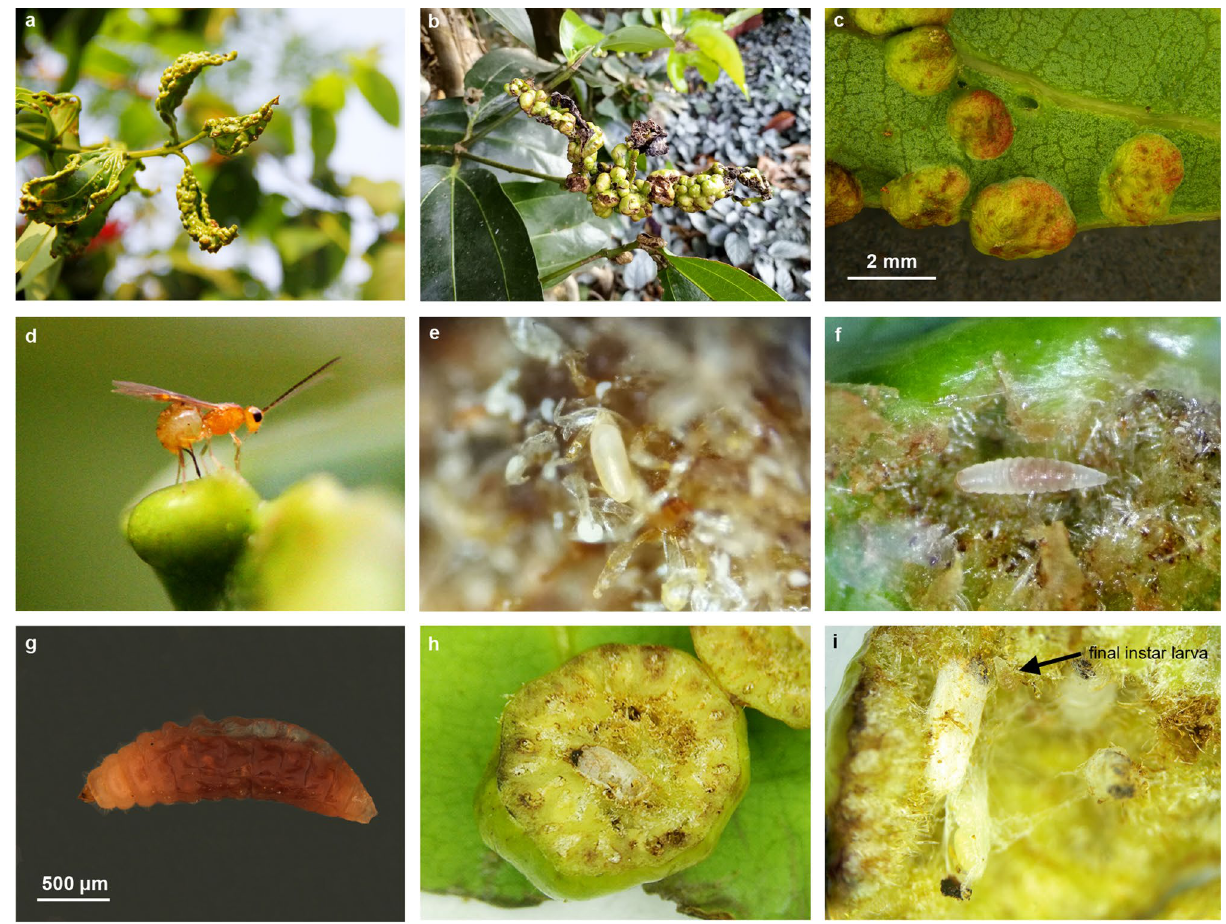
Figure 1. Leaf galls induced by Aceria doctersi (Nalepa) on Cinnamomum verum J.Presl. and life history of Bracon predatorius Ranjith & Quicke sp. nov. (a–c ) Leaf galls of C. verum induced by A. doctersi ( a ) young leaf galls, ( b ) mature and dehisced leaf galls, ( c ) light microscopic image of leaf galls, ( d–i ) biology of B. predatorius ( d ) adult female wasp ovipositing into the leaf gall, ( e ) egg, ( f ) final instar larva, ( g ) light microscopic image of final instar larva, ( h ) cut opened gall with single pupa, ( i ) larva and pupae in